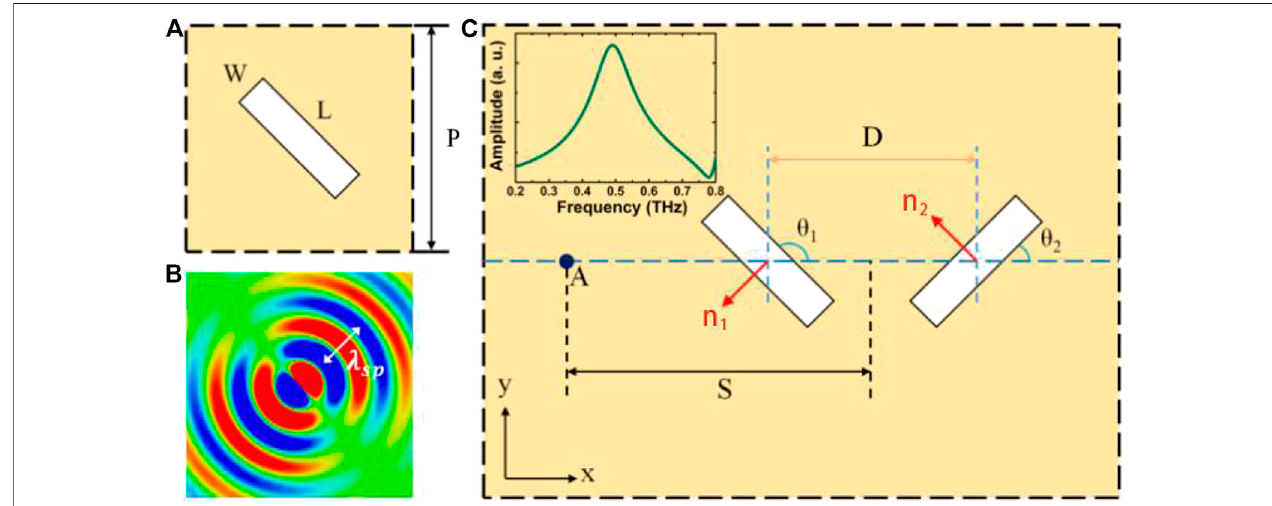
FIGURE1|(A) Theunitcellschematicoftheproposedmetasurface. ThegeometricparametersofthemicroslitwereL (cid:2) 200 μ m,W (cid:2) 50 μ m,and p (cid:2) 300 μ m. (B) The simulatedSPradiationpattern wasexcitedbyanarrow sub-wavelength microslitonthealuminum fi lmunder theincidence ofanormal plane wave. (C) Aschematic diagramofapairofmicroslitresonators.TheywereusedtoderivetheSPemission fi eldatpointAatadistanceSfromthecenterofthepairofmicroslits.Disthedistance between the centers of the